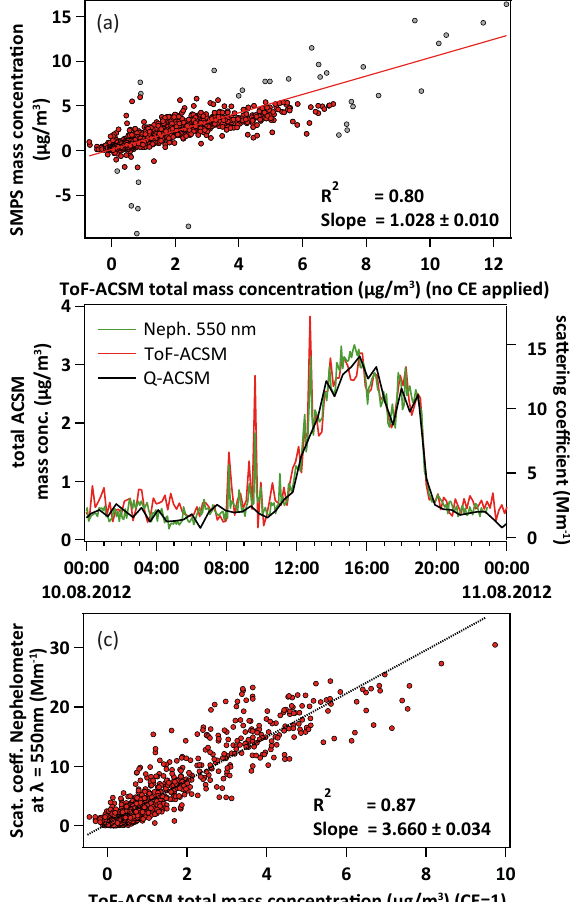
Fig. 8. (a) Scatter plot of the mass concentration calculated from an SMPS vs. the one from the ToF-ACSM. Greyed points were omitted in the linear orthogonal regression (red line). The two instruments correlate well ( R 2 = 0 . 80) and from the slope (1.028) a CE value close to unity (0.97) can be derived. (b) Total mass concentrations measured on 10 August 2012 with the ToF-ACSM (CE=1, red line, time resolution: 10min), the Q-ACSM (CE=1, black line, time res- olution: 30min) and a nephelometer ( λ = 550nm, green line, time resolution: 5min). The short-term plumes were detected by ToF- ACSM and nephelometer but not by the Q-ACSM. (c) Scatter plot of the scattering coefficient of the λ = 550nm channel of a neph- elometer vs. the mass concentration from the ToF-ACSM. Periods with supermicron or mineral dust particles were excluded. There is a good correlation between the scattering coefficient and the mass concentration of the ToF-ACSM ( R 2 = 0 . 87), and the slope (3.66m 2 g − 1 ) lies within the range of previously reported MSEs (DeCarlo et al., 2008; Shinozuka et al., 2007). measurement period. The greyed-out data points (one hour averages) were ignored in the displayed linear orthogonal